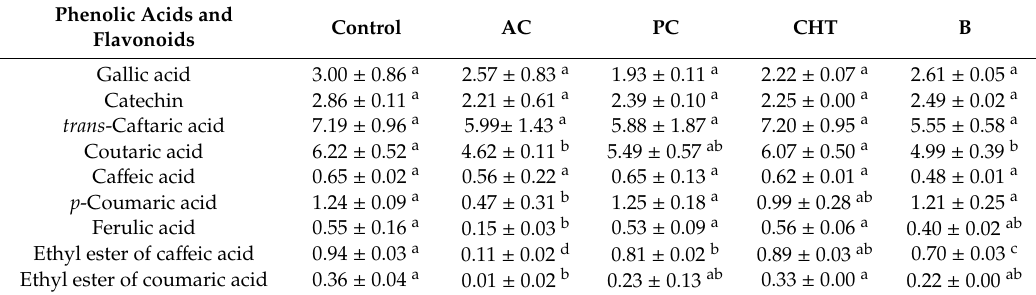
Table 4. E ff ect of fining agents’ application on phenolic acids (mg / L) and flavonoids (mg / L) in white